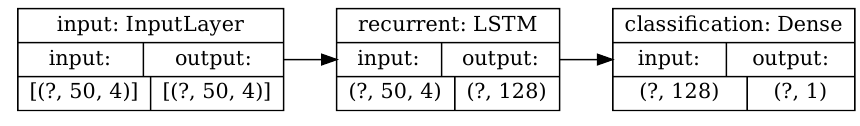
Figure 12. Sketch of the architecture of the TATA-Box classification